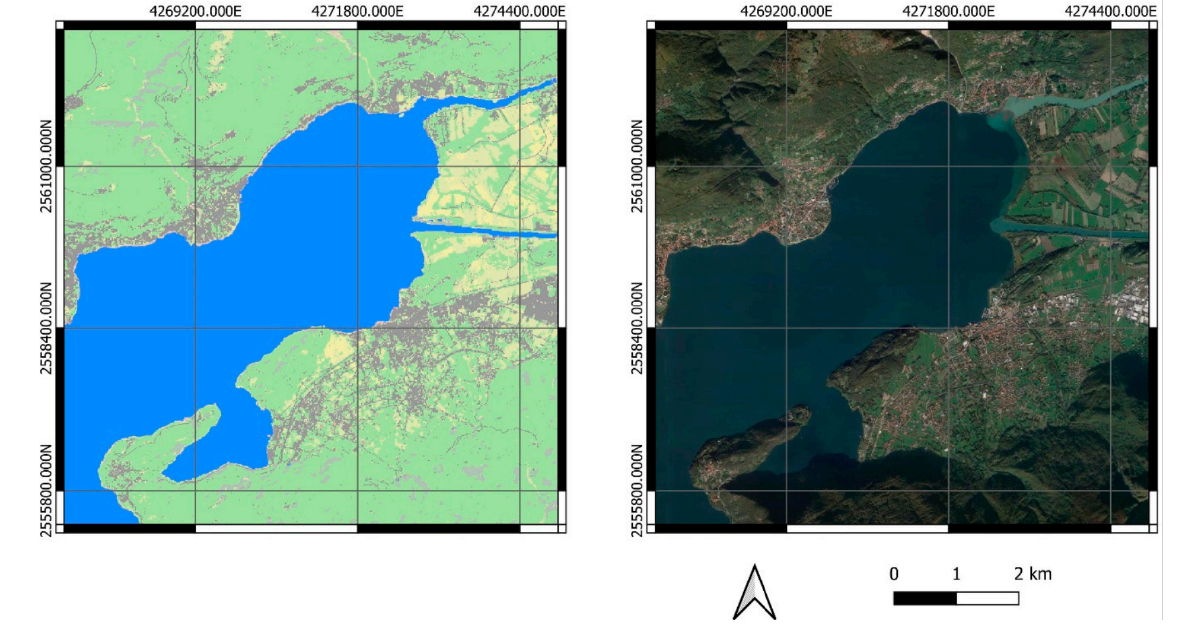
Figure 7. Water bodies.